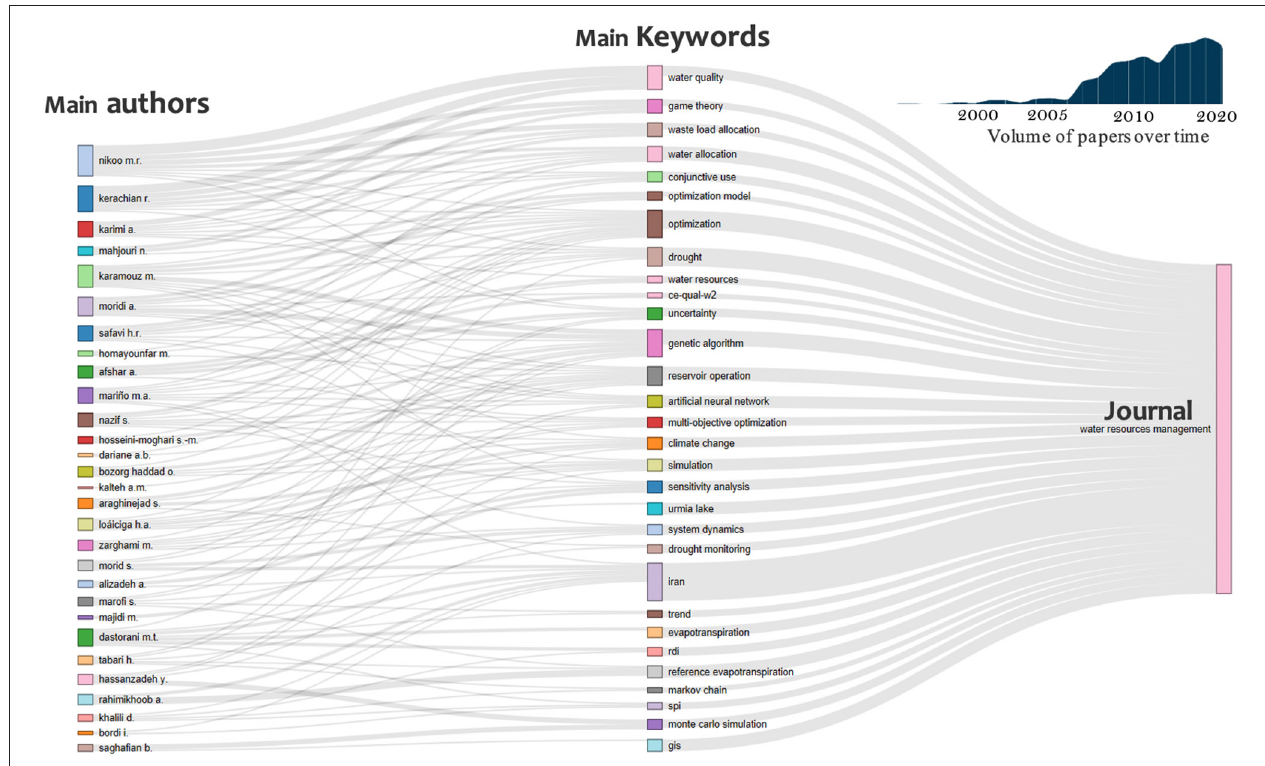
FIGURE 5 | Visualizing the volume of papers, and how top authors and keywords associate (S-K-J Snaky diagram) in the Journal of Water Resource Management based on [“Water resource management” or “water management”] AND [Iran], (1995–2020); Source: Scopus.